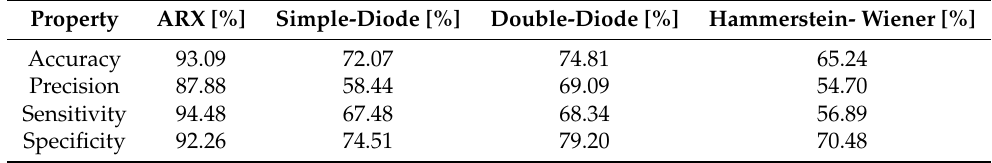
Table 9. Fault detection results for the Diode, ARX, and Hamerstein models in photovoltaic systems. Property ARX